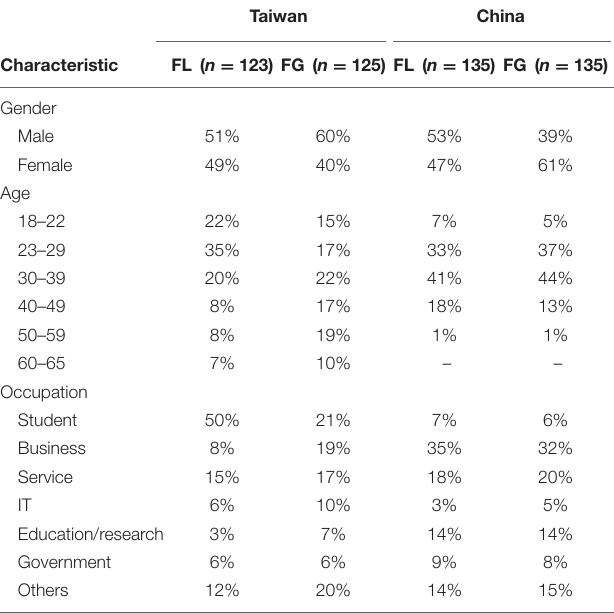
TABLE 1 | Sample characteristics as a percentage of the sample for Study 1. Taiwan China